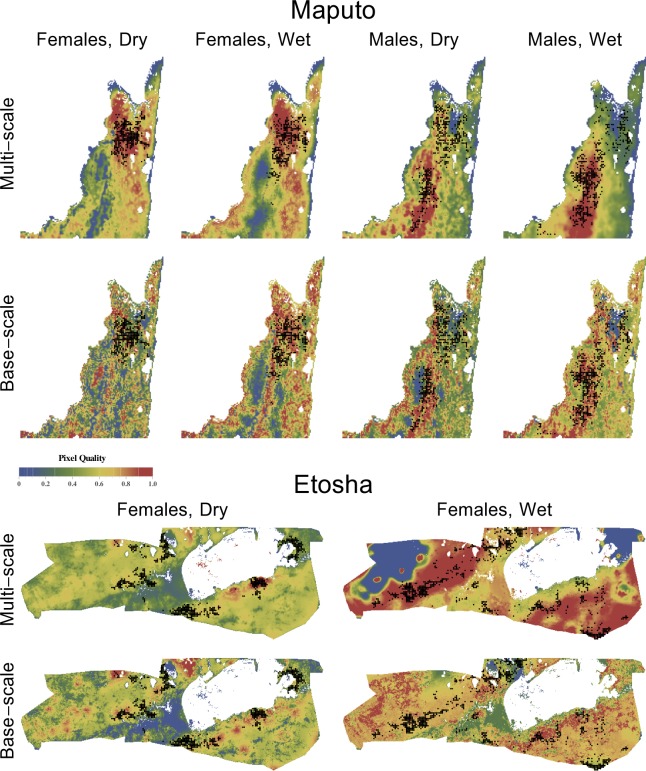
Landscape-wide relative quality maps.The maps were overlaid with the endpoint of each movement for all elephant data sets, representing the composite of all variables present in the best multi-scale model and the original, base-scale variables only.